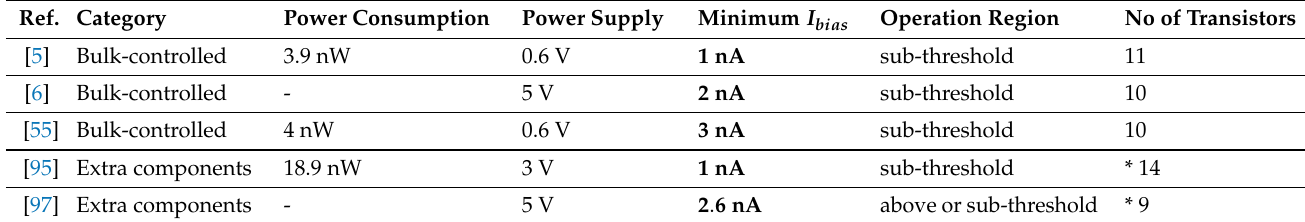
Table 13. Gaussian Function Circuits performance summary and comparison. *Additional current sources. Ref.